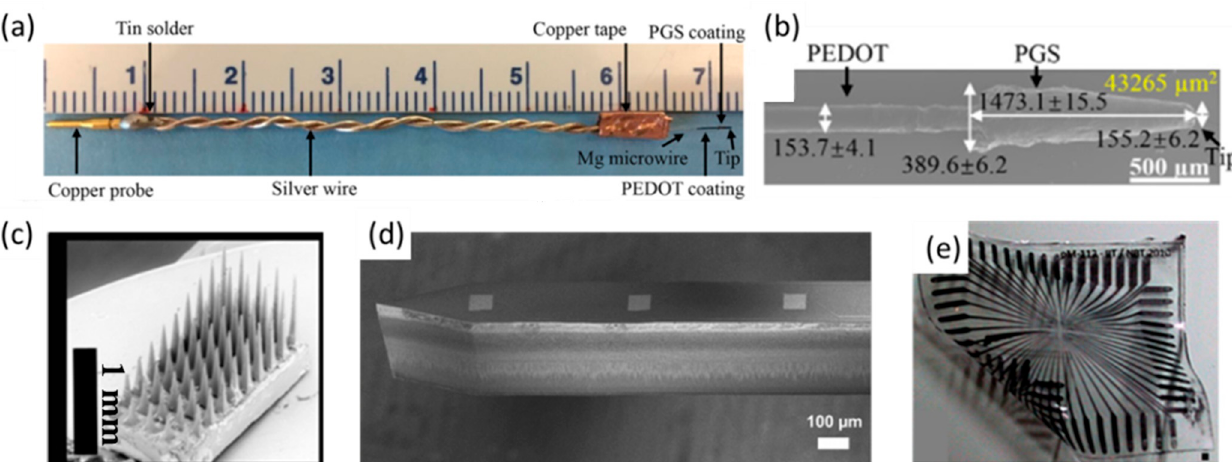
Figure 1. The macroscopic image ( a ) and morphology ( b ) of an Mg-based microwire electrode. An illustration of Utah-type ( c ), Michigan-type ( d ) and PDMS-based electrodes ( e ). ( a , b ) are reproduced with permission from [14], Copyright 2020, Elsevier. ( c ) is reproduced with permission from [18], Copyright 2014, iopscience.iop.org. ( d ) is reproduced with permission from [19], Copyright 2015, Elsevier. ( e ) is reproduced with permission from [27], Copyright 2011, Elsevier.